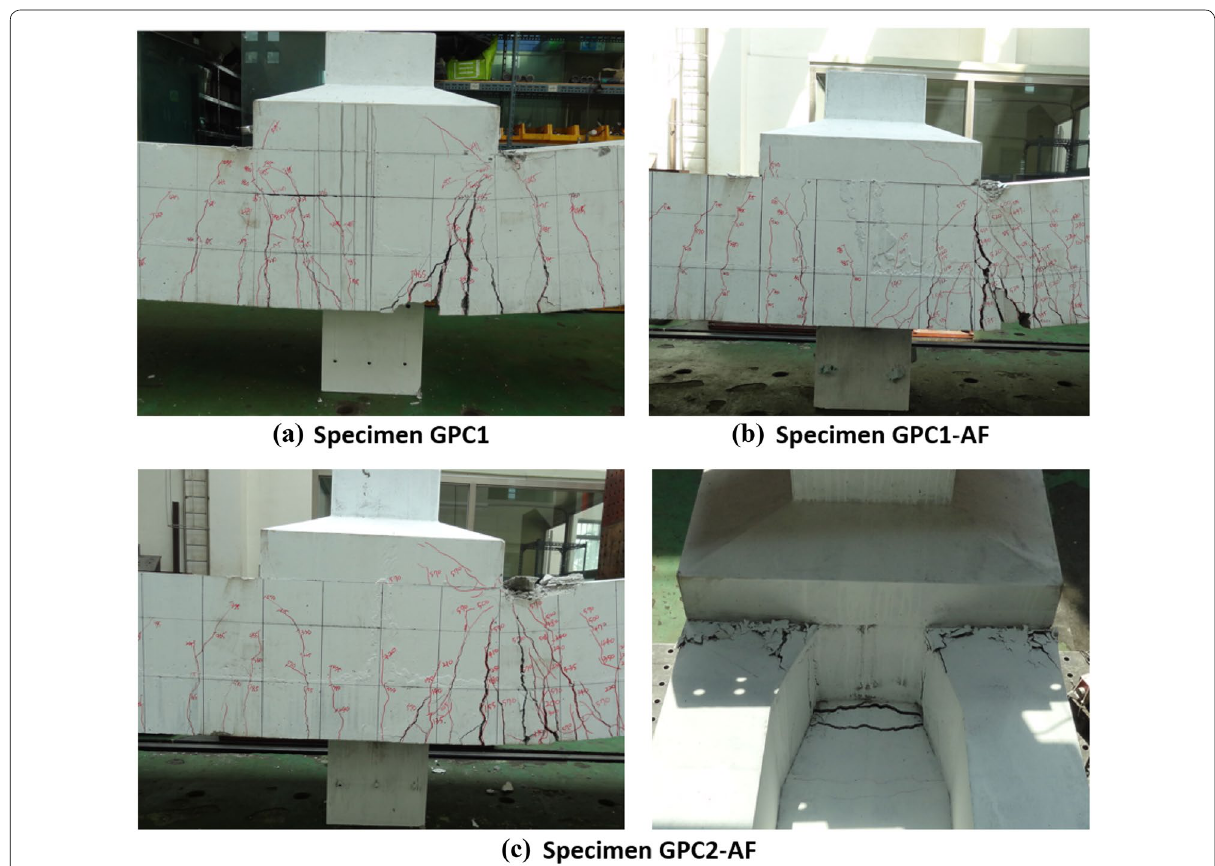
Fig. 10 Damage modes of specimens under gravity loading at the end of the